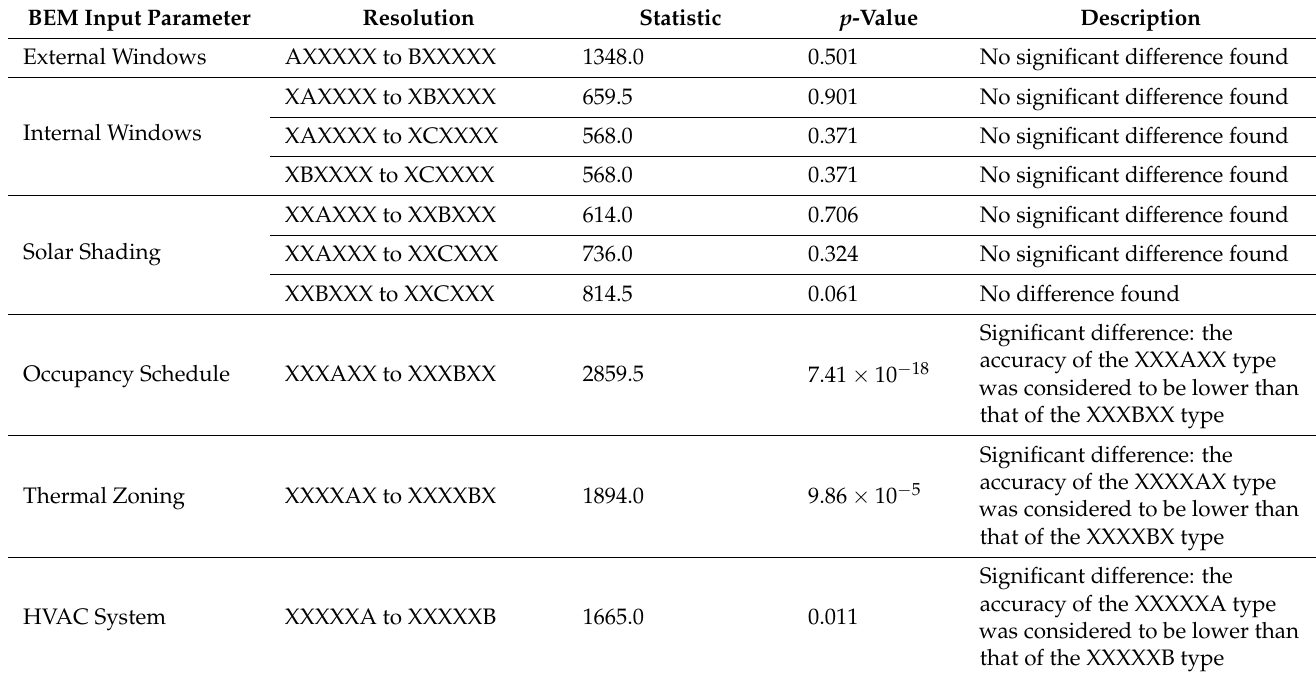
Table 5. The analysis of U-testing for the CVRMSE boxplot (energy consumption).